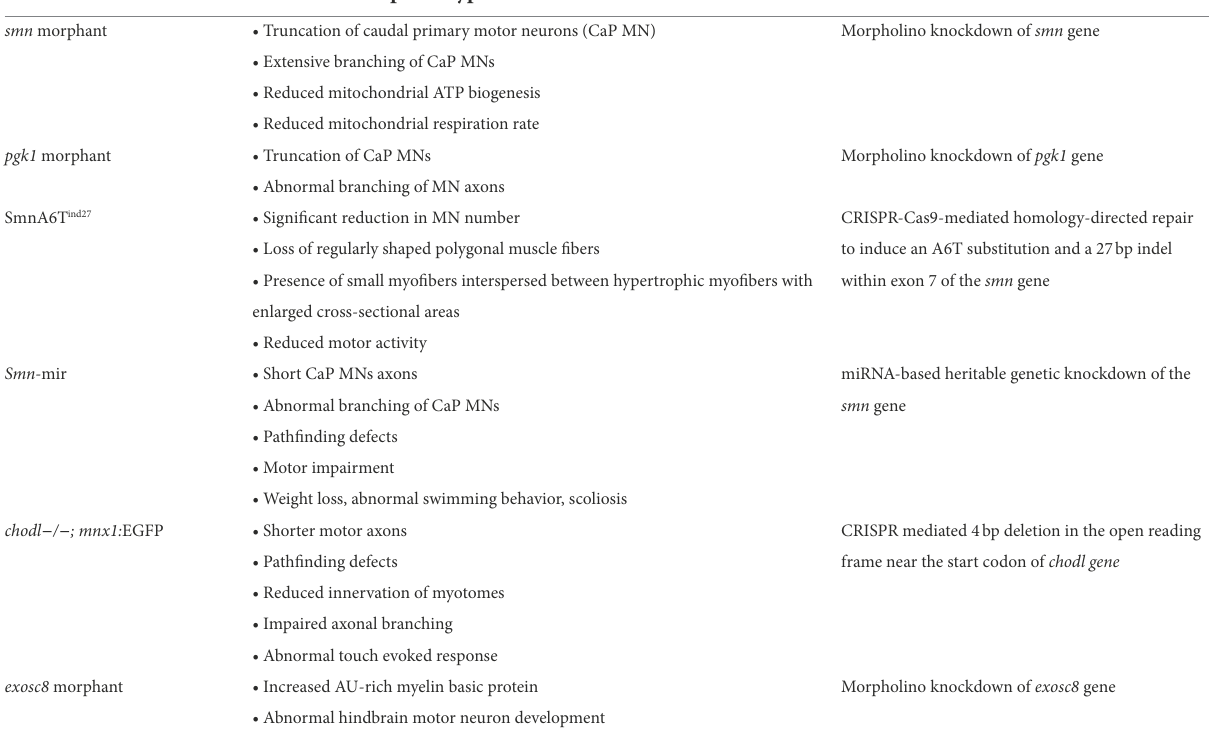
TABLE 1 Zebrafish SMA models and their distinct